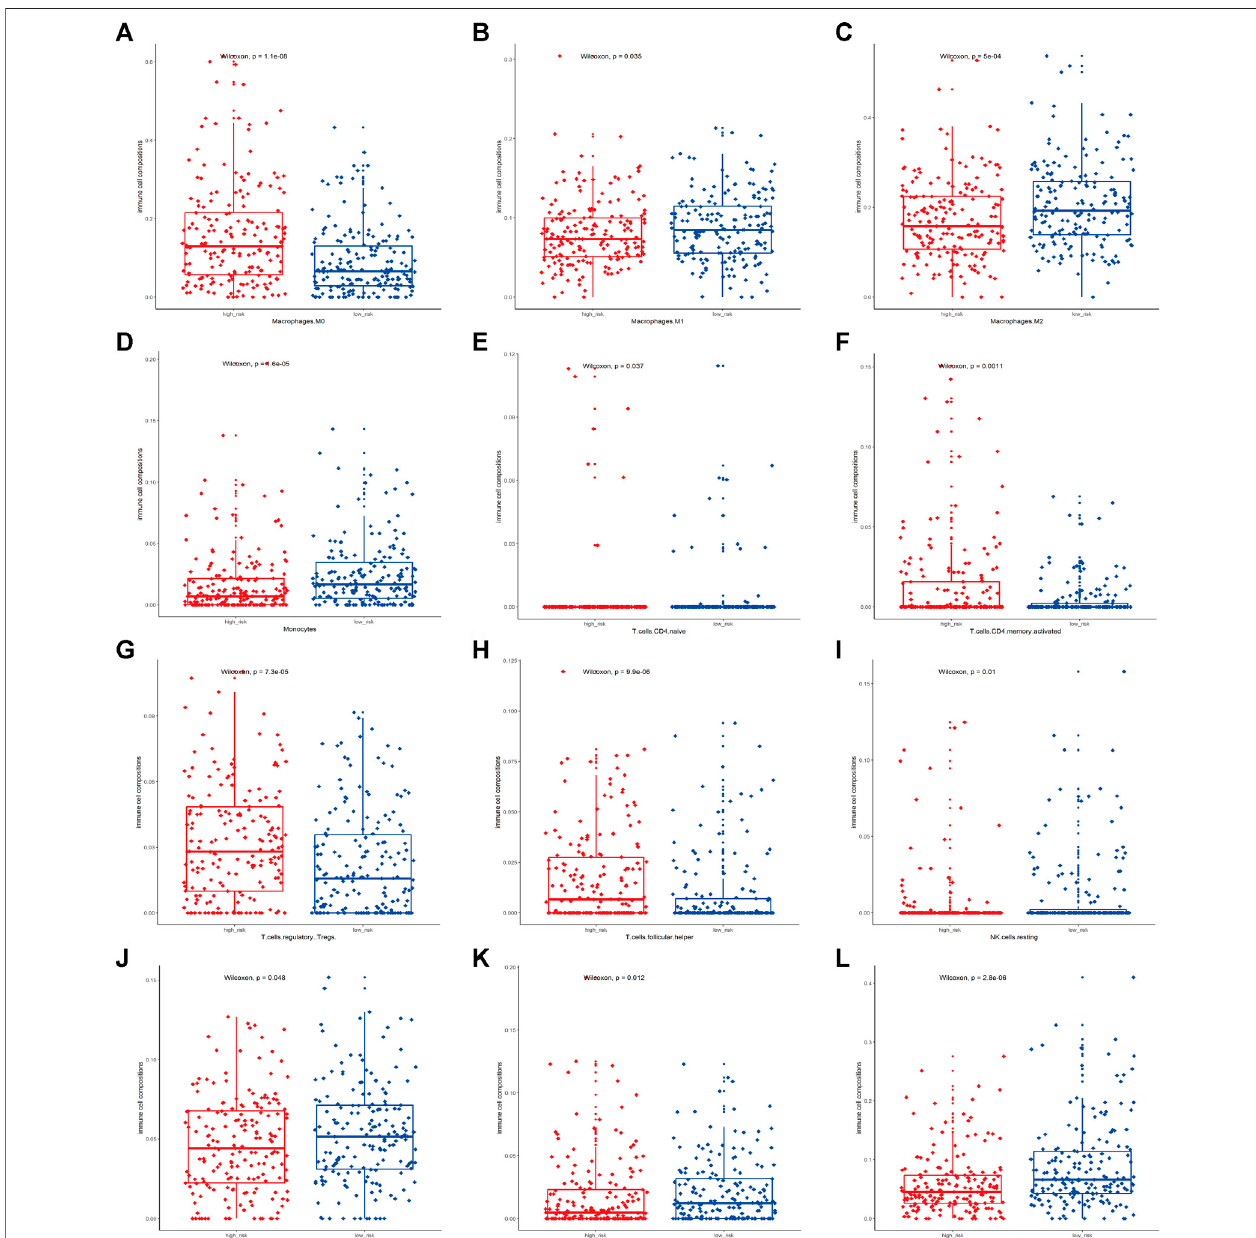
FIGURE 5 | Association between the risk score of the signature and immune cell in fi ltration. (A – L) presented relative expression of M0 macrophages, M1 macrophages,M2macrophages,Monocytes,naïveCD4 + Tcells,activatedCD4 + memoryTcells,regulatoryTcells(Tregs),follicularHelperTcells(Tfh),restingNKcells, activated NK cells, naïve B cells, and resting Mast cells ( p < 0.05) between the low-risk and high-risk group,